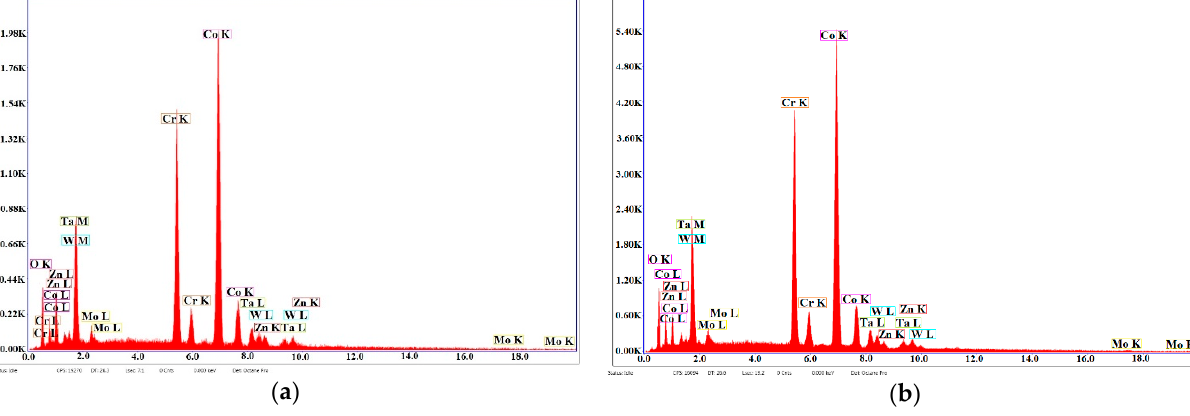
Figure 7. EDS analyses of samples of Co-Cr alloy fabricated by DMLS and coated with a thin film of Ta 2 O 5 by an e-gun for: ( a ) sample S5 with post-treatment; ( b ) sample S6 without post-treatment.